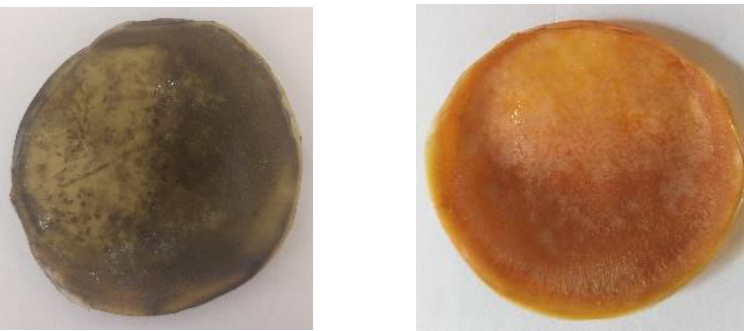
Figure 5. The membranes containing 20 wt.% of N,N’ -bis(salicylidene)ethylenediamine after sorp- tion ( A ) and desorption ( B ).